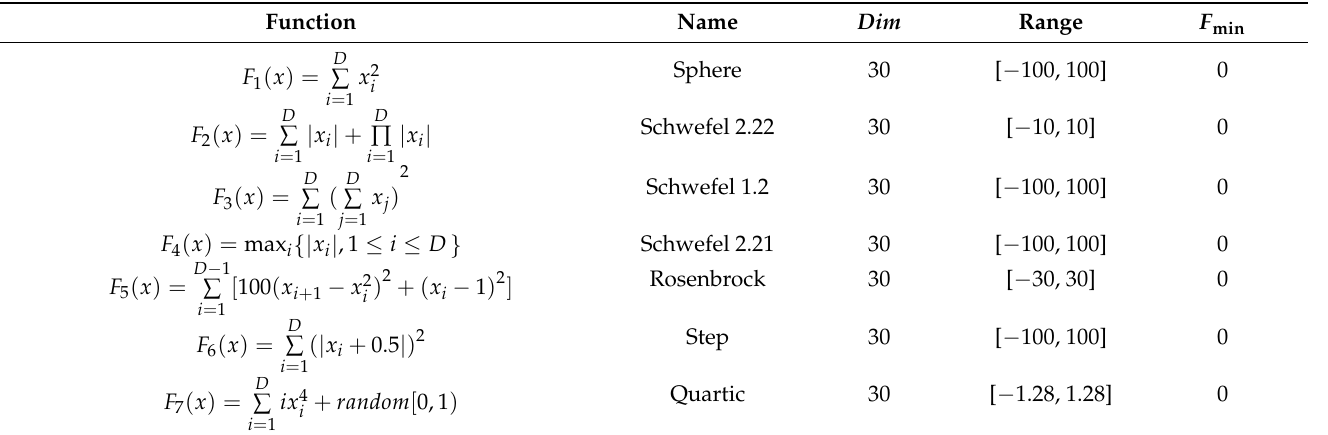
Table 1. Unimodal benchmark